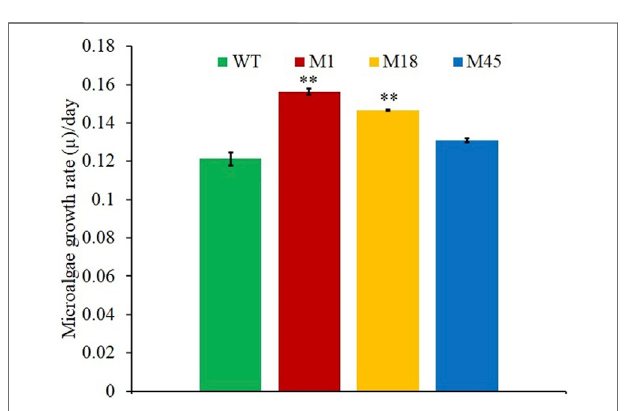
FIGURE 3 | Growth rate per day comparisons of mutants M1, M18, M45, and wild-type N. oculata , incubated at 130 μ mol m − 2 s − 1 , 20 ° C, under a 12-h/12-h (light/dark) cycle and 160 RPM shaking for ten days. Mean ± standard deviation is shown ( n = 3) and t -tests determine the statistical signi fi cance ( p < 0.05 [*]; p < 0.01 [**]; and p < 0.001 [***]) of the M1 mutant strain compared to the wild-type